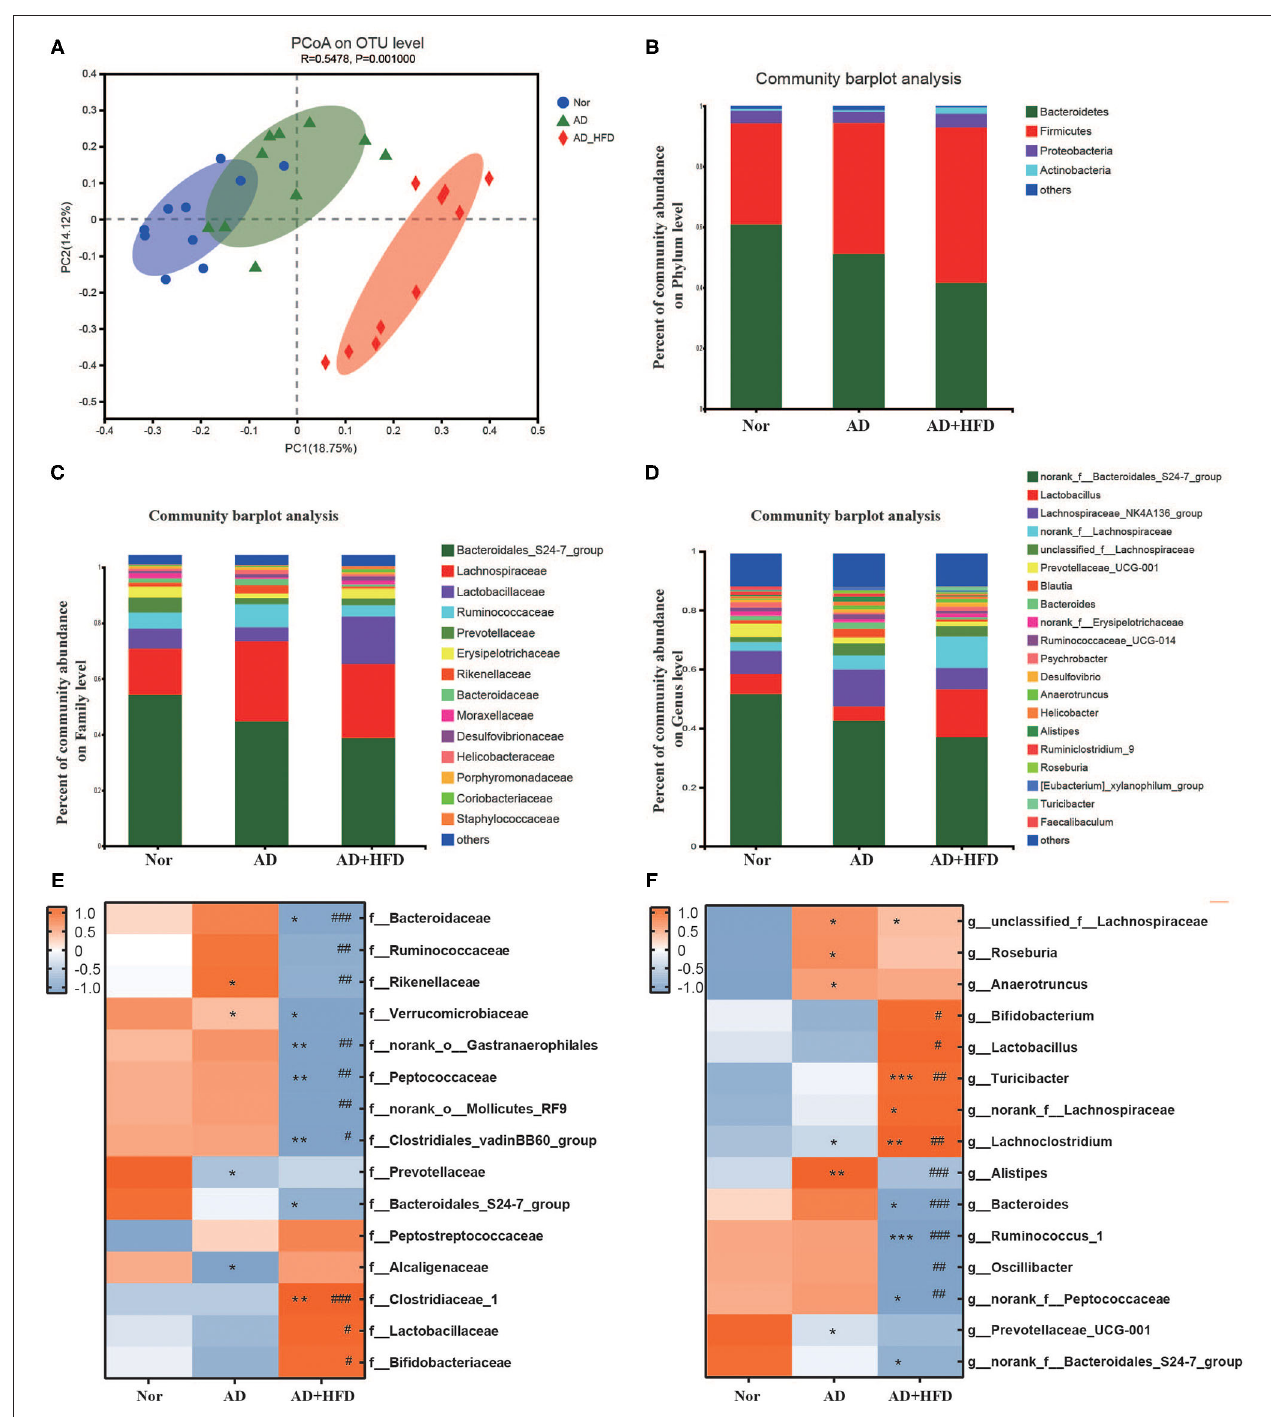
FIGURE 4 | High fat diet altered the fecal microbiota in APP/PS1 mice. (A) PcoA based on the distance matrix of Bray-Curtis dissimilarity of the gut microbiota communities in the Nor, AD, and AD + HFD mice on the operational taxonomic unit (OTU) level. (B–D) The relative abundance of gut microbes of Nor, AD, and AD + HFD groups on Phylum, Family and Genus level, respectively. Heatmap of significant gut microbiota changes represented at the Family (E) , Genus (F) level. Colors on the heatmap indicate the relative abundance of gut microbiota. Gut microbiota with significant changes were chosen using a Wilcoxon rank-sum two-tailed test with P < 0.05. * p < 0.05,** p < 0.01,*** p < 0.001 (compared to Nor group); # p < 0.05, ## p < 0.01, ### p < 0.001 (compared to AD group).